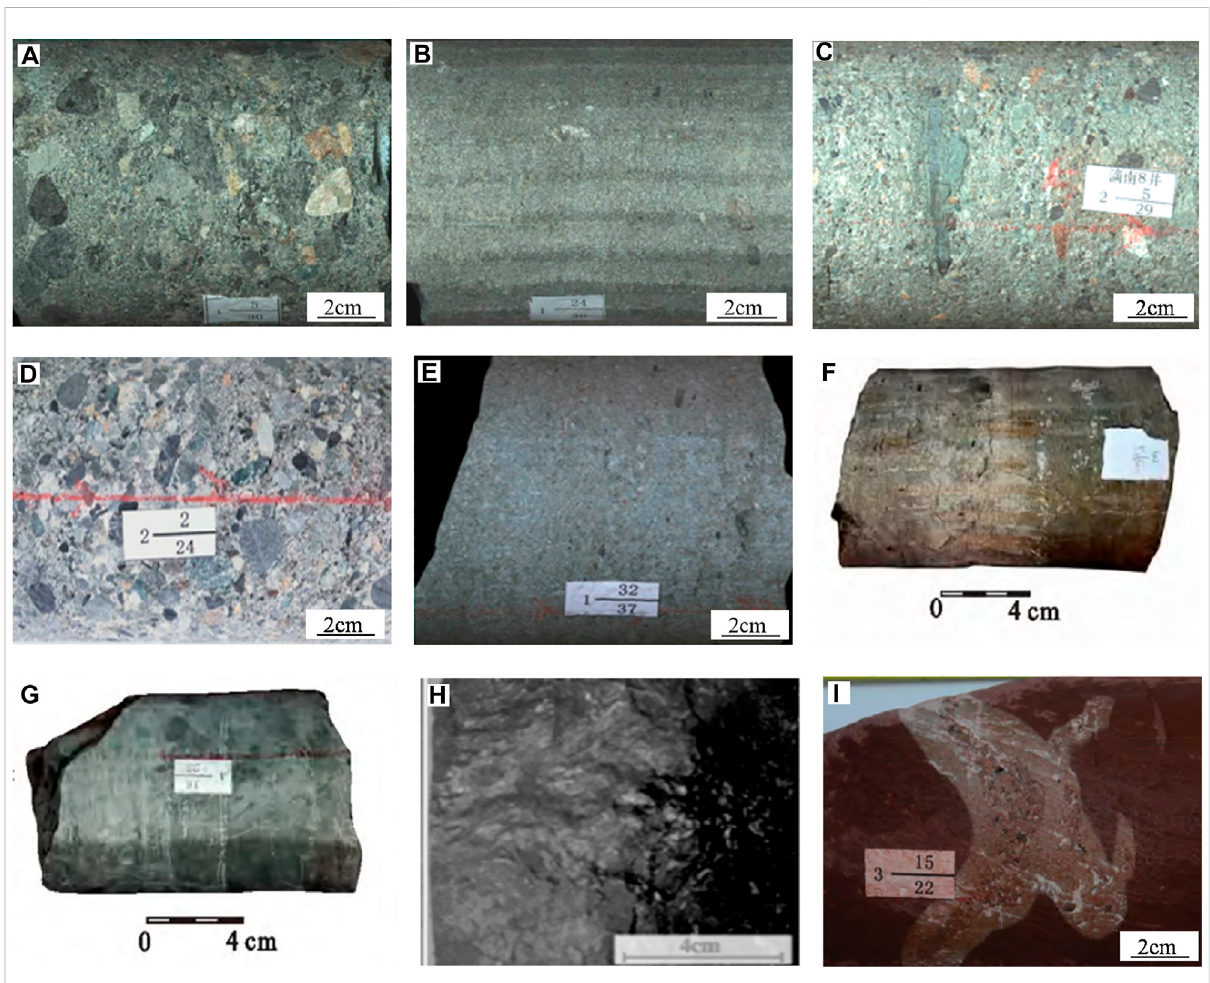
FIGURE 2 Basic lithological characteristics of the Upper Wuerhe Formation in the study area. (A) Glutenite, Dinan 19 well, P 3 w 1 , 3,922.37 m – 3,922.52 m; (B) Pebbly sandstone, Dinan 19 well, P 3 w 1 , 3,922.37 m – 3,922.52 m; (C) Glutenite, Dinan 15 well, P 3 w 2 , 3,732.99 m – 3,733.17 m; (D) Glutenite, Dinan 15 well, P 3 w 2 , 3,792.18 m – 3,792.36 m; (E) . Pebbly sandstone, Dinan 15 well, P 3 w 2 , 3,738.56 m – 3,738.65 m; (F) Medium – fi ne sandstone, J202 well -13/27(Zouetal.,2021); (G) Mudstone,siltstone,K82well4 – 16/26(Zouetal.,2021); (H) Brownmudstone,MH014well,3,736.98